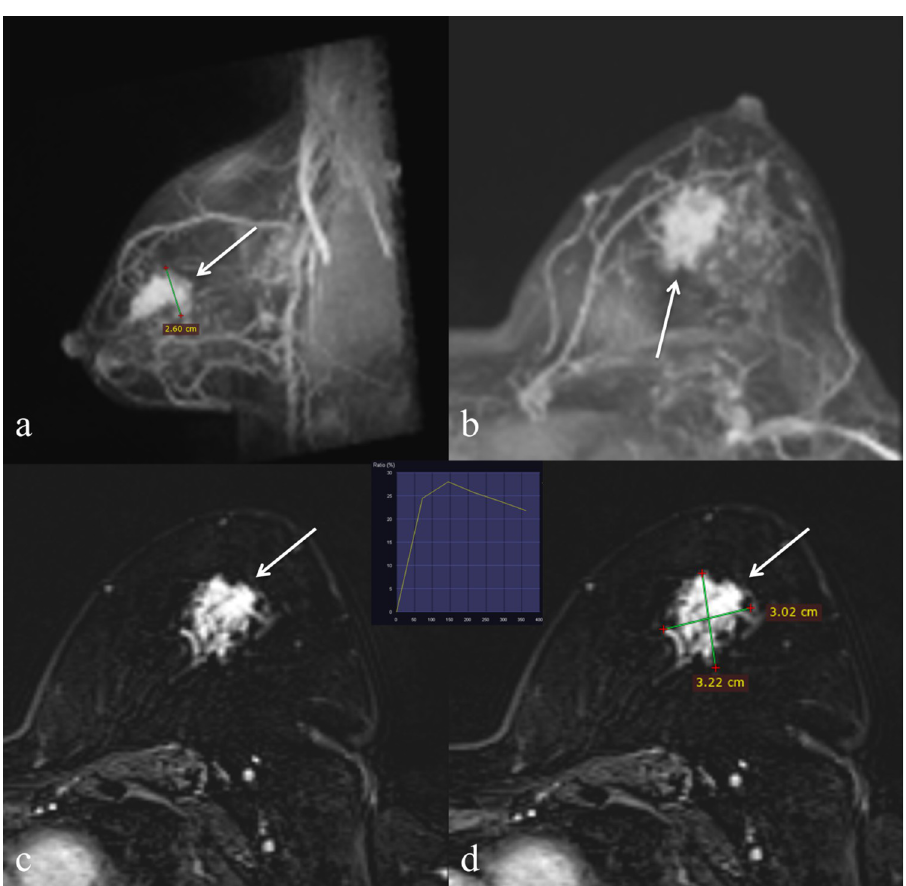
Fig 7. 49-year-old woman with left breast invasive carcinoma who was deemed eligible for IORT based on conventional imaging but the tumour was larger than 30 mm on MRI (done 4 days apart). Breast MRI Images maximal intensity projection (MIP) in (A) sagittal and (B) axial projections showing the index tumour (thin arrow). (C, D) Axial DCE phase 1 showing index tumour (thin arrow) with a maximal diameter (AP) of 32mm on MRI.